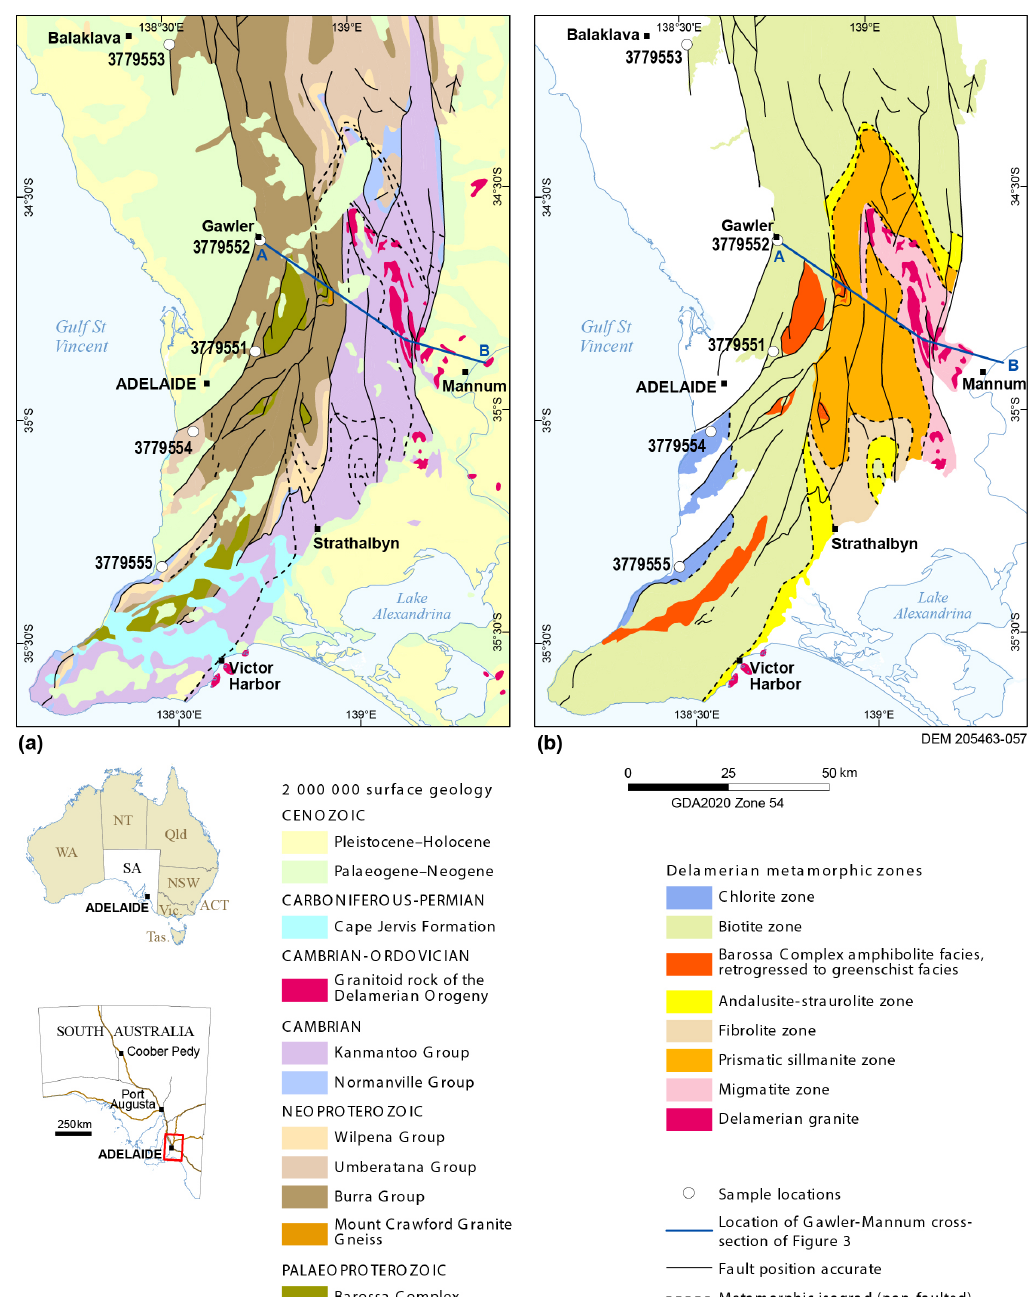
Figure 2. Geology of the Mt. Lofty Ranges, part of the Delamerian Orogen, showing the location of samples analysed in this study. (a) 1:2 million scale South Australian state-wide geology data set. (b) Delamerian metamorphic isograds of the Mt. Lofty Ranges (fol- lowing Offler and Fleming, 1968; Mancktelow, 1990; Dymoke and Sandiford, 1992; Preiss, 1995a).